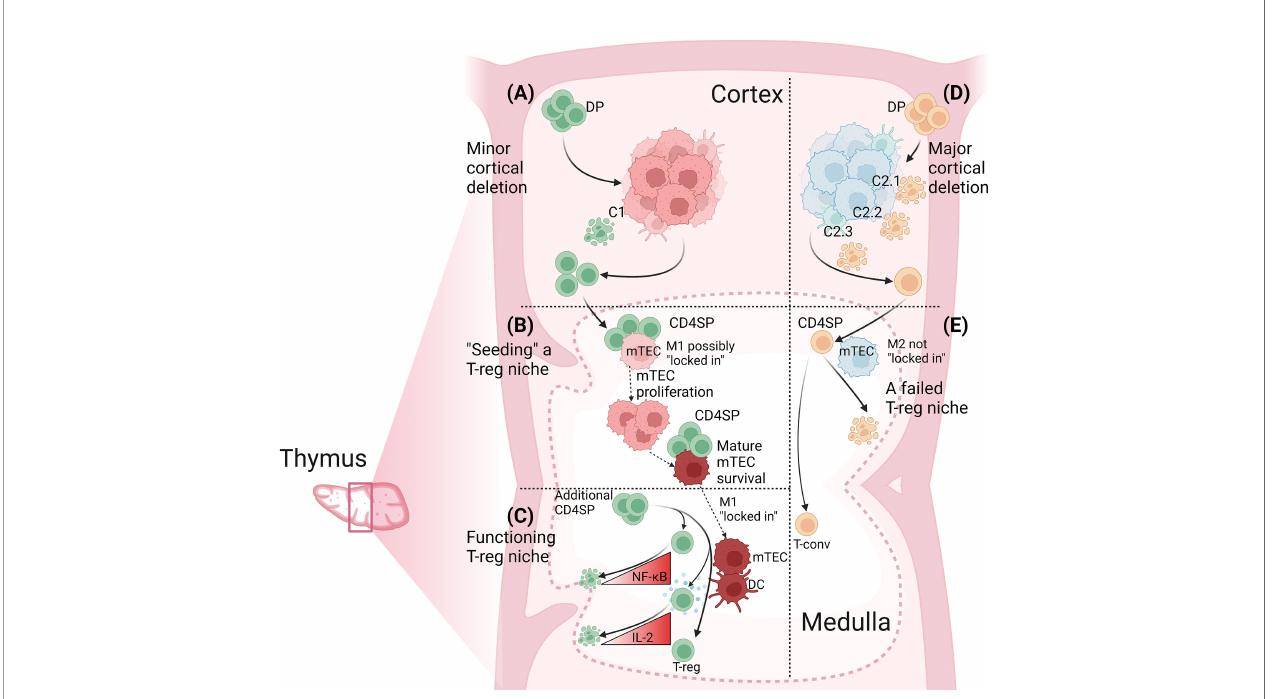
FIGURE 2 | Determinants of antigen-speci fi c T-reg niche size in the thymus. (A) The extent of cortical deletion is minor when the relatedness between cortical and medullary peptides is low. Out of four DP thymocytes speci fi c for a medullary peptide, M1, one is deleted by a related cortical peptide, C1, and the other three progress to the CD4SP stage and migrate into the medulla. (B) Cognate CD4SP-mTEC interactions “ seed ” the T-reg niche. CD4SP thymocytes could mediate this effect by interacting with immature mTEC prior to the onset of proliferation and/or by promoting mTEC survival at the post-cycling stage through sustained engagement of RANK, CD40 and LT b R expressed on mTEC. The key outcome is that M1-speci fi c CD4SP thymocytes induce the M1-presenting mTEC to “ lock in ” M1 expression. (C) A functioning T-reg niche. By now, the mature M1-expressing mTEC has high expression of MHCII, CD80, Aire and the protein from which the M1 peptide is derived. M1- speci fi c CD4SP thymocytes also induce local DC to increase MHCII and CD80 expression. M1-speci fi c CD4SP thymocytes also produce IL-2. However, most M1- speci fi c CD4SP thymocytes undergo deletion due to insuf fi cient NF- k B activation or insuf fi cient IL-2 consumption. Rare M1-speci fi c CD4SP thymocytes activate suf fi cient NF- k B and consume suf fi cient IL-2 to survive, upregulate Foxp3 and progress to the next stage of T-reg development. (D) The extent of cortical deletion is major when the relatedness between cortical and medullary peptides is high. Out offour DP thymocytes speci fi c for medullary peptide, M2, three are deleted in the cortex by related self-peptides, C2.1, C2.2 and C2.3, and only one progresses to the CD4SP stage and migrates into the medulla. (E) A failed T-reg niche. The number of M2-speci fi c CD4SP thymocytes is too low to provide inductive signals to the M2-expressing mTEC. The mTEC may switch off expression of M2 and switch on expression of different self-antigens. Activation of M2-speci fi c CD4SP thymocytes is insuf fi cient to induce T-reg development but may be suf fi cient to induce deletion of some cells. No M2- speci fi c T-reg niche forms and the small M2-speci fi c CD4SP population develops into T-conv cells. Figure created with